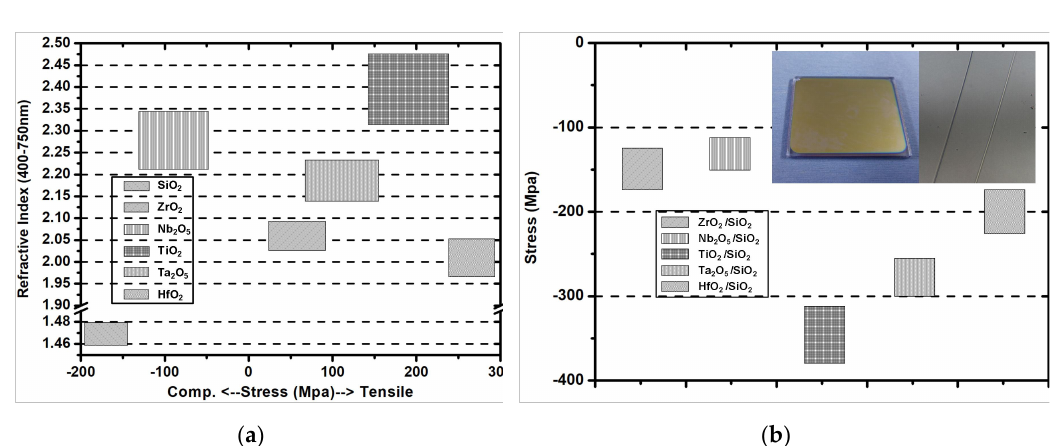
Figure 4. ( a ) Refractive index of different coating materials, including SiO 2 , TiO 2 , Ta 2 O 5 , ZrO 2 , HfO 2 , and Nb 2 O 5 ; ( b ) Stress test results of 30 layers HR coating samples of different high and low refractive index material combination, image in the plot exhibit the rupture of HR coating caused by large coating stress.